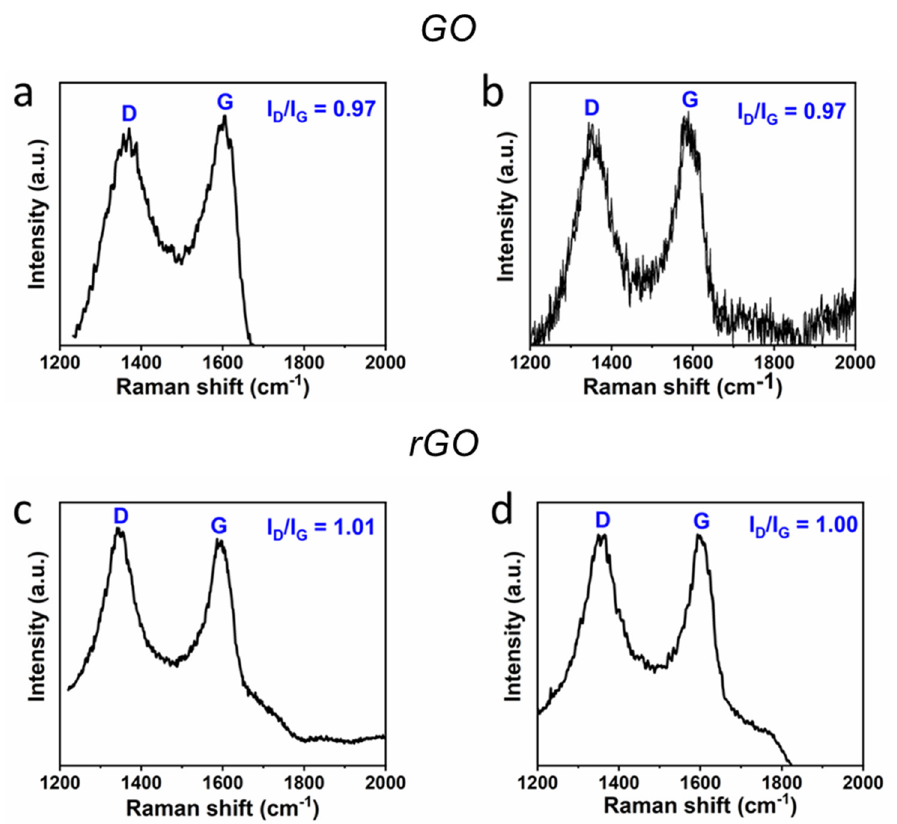
Figure 2. Raman spectra of GO flakes on Si/SiO2 before ( a ) sterilization and after ( b ) sterilization in an autoclave. Raman spectra of rGO flakes on Si/SiO2 before ( c ) sterilization and after ( d ) sterilization in an autoclave.